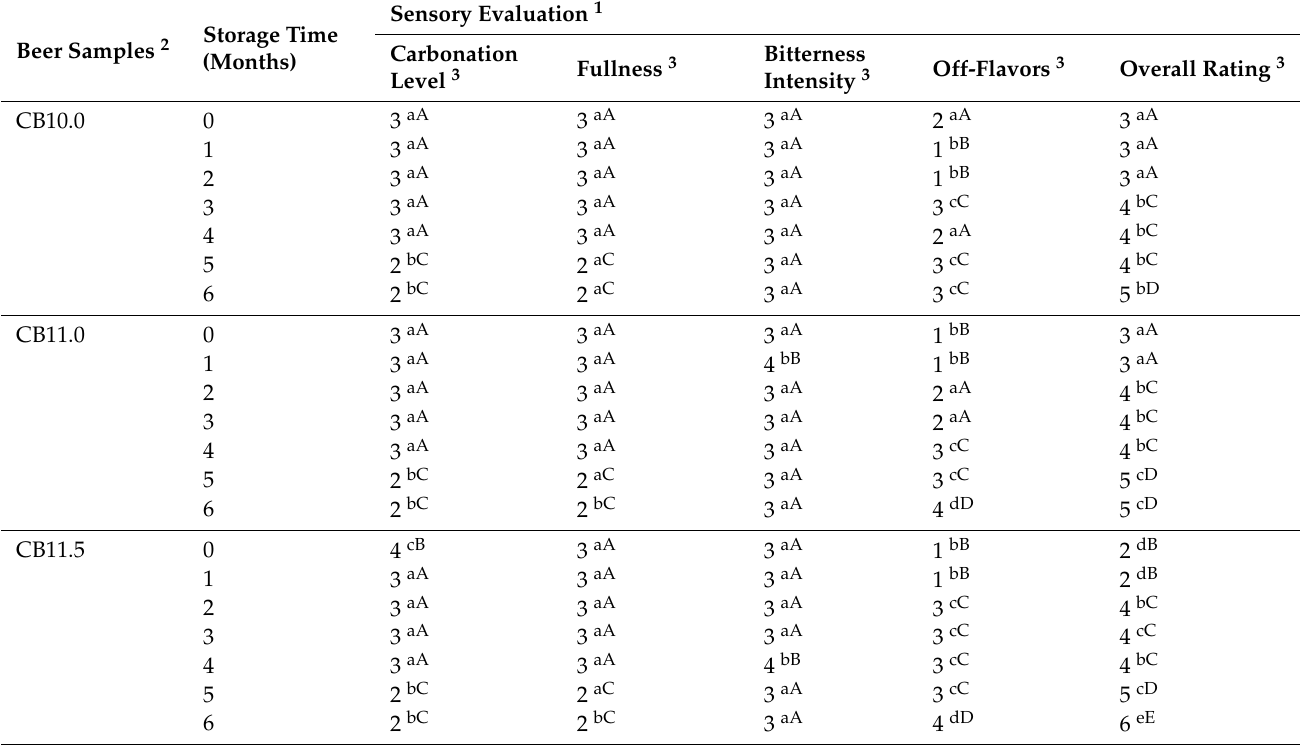
Table 3. Sensory attributes of the beer samples (carbonation level, fullness, bitterness intensity, off-flavors and overall